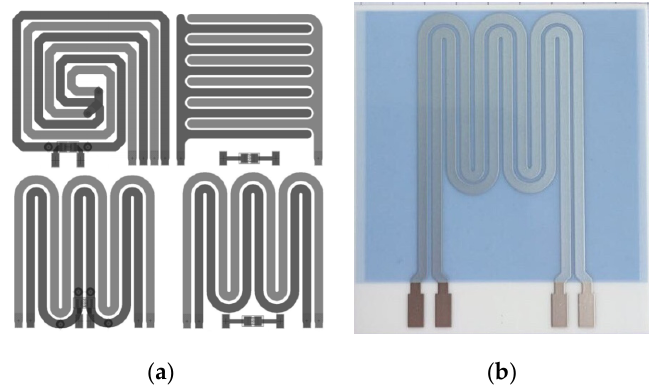
Figure 2. Schematic pictures of the produced sensor structures. ( a ) Sensor structures produced as flexible PCBs (top left to bottom right): double spiral structure S1, comb structure K1, double mean- der structures M1 and M2. Although the two electrical conductors (electrodes) are both made of (identical) copper, they are shown in different colours for reasons of clarity. ( b ) Photo of a rigid PCB with double meander structure M2 (ceramic substrate material).